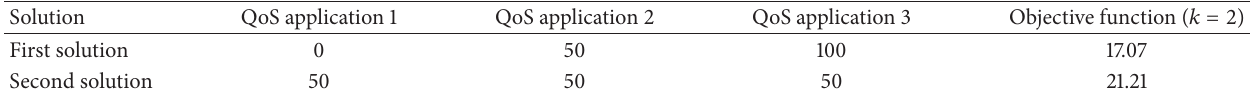
Table 3: QoS results with 𝑓2